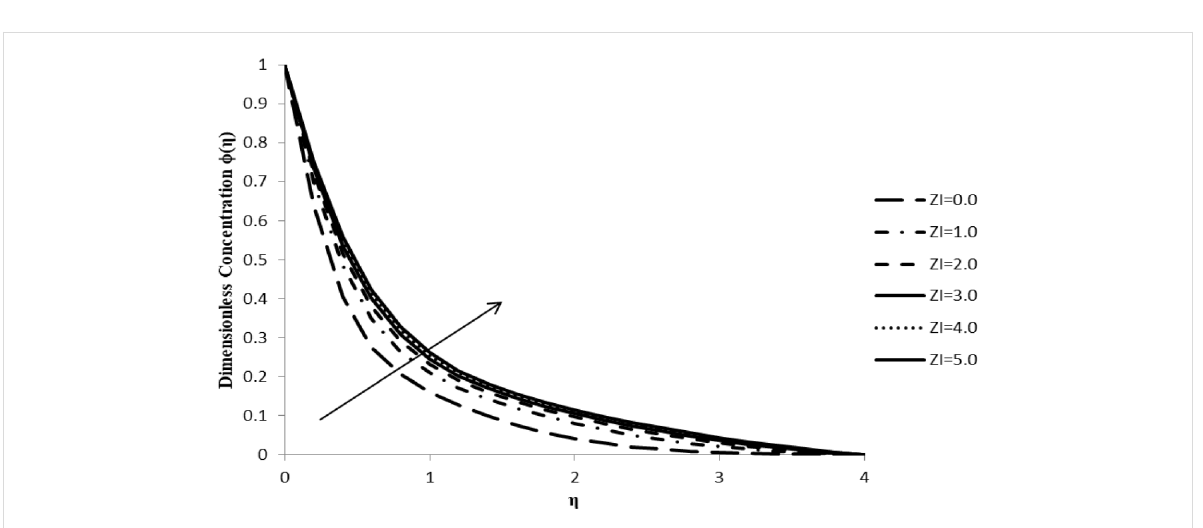
Figure 4: Influence of the slip parameter for liquids ξ on the concentration distribution ϕ ( η ) when n = 2.0, M = 0.0, Q = 0.0, Pr = 2.0, Nb = Nt = 0.5, Le = 5.0, and F w = 0.2.